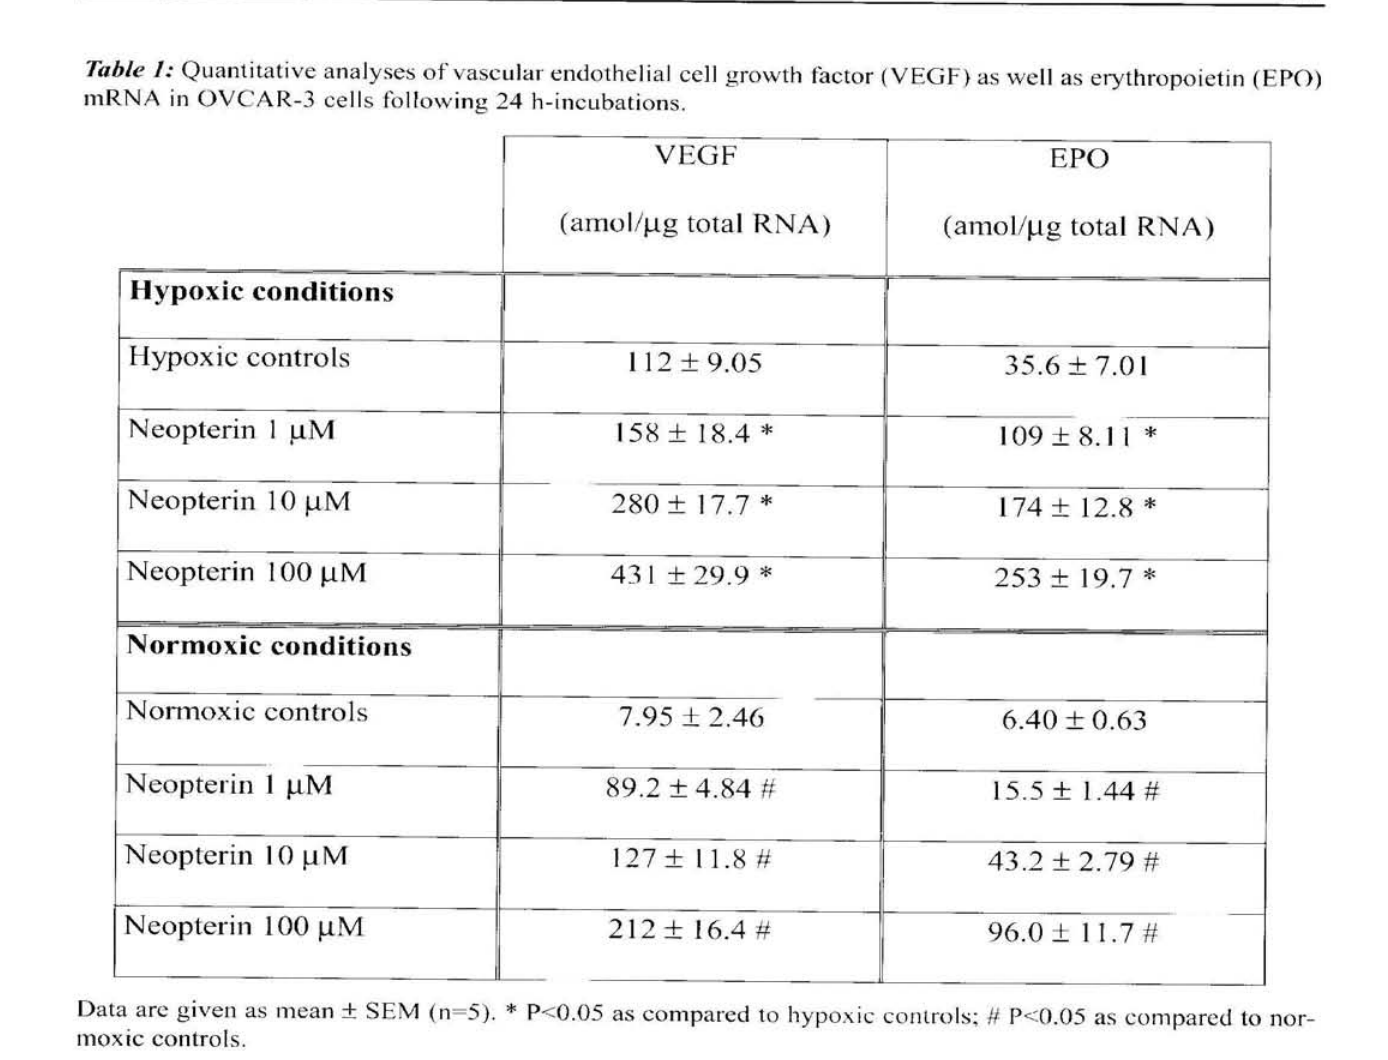
Table 1: Quantitative analyses of vascular endothelial cell growth factor (VEGF) as well as erythropoietin (EPO) mRNA in OVCAR-3 cells following 24